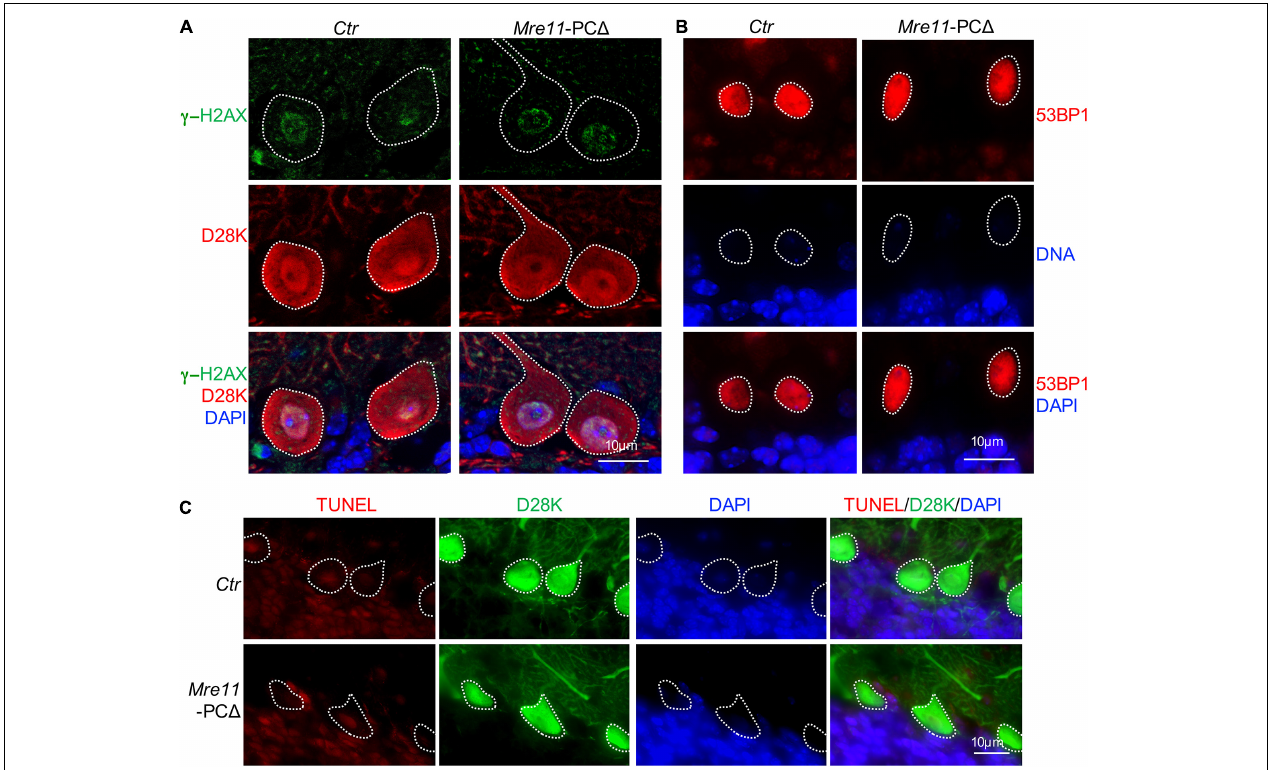
FIGURE 5 | Deletion of Mre11 did not lead to damage accumulation in Purkinje cells. (A) Sagittal sections of 18-month-old control ( Ctr ) and Mre11 -PC (cid:49) mice were stained with γ -H2AX (green), Calbindin-D28K (D28K, red), and DAPI (blue) to label DNA damage, Purkinje cells, and DNA, respectively. Dotted lines highlight Purkinje cells. (B) Sagittal sections of 18-month-old Ctr and Mre11 -PC (cid:49) mice were stained with 53BP1 (red) and DAPI (blue) to label damaged DNA and nuclei, respectively. Dotted lines highlight the nucleus of Purkinje cells. (C) Sagittal sections of 18-month-old Ctr and Mre11 -PC (cid:49) mice were stained with Calbindin-D28K (D28K, green), TUNEL (red), and DAPI (blue) to label Purkinje cells, apoptotic cells, and DNA, respectively. Dotted lines highlight Purkinje